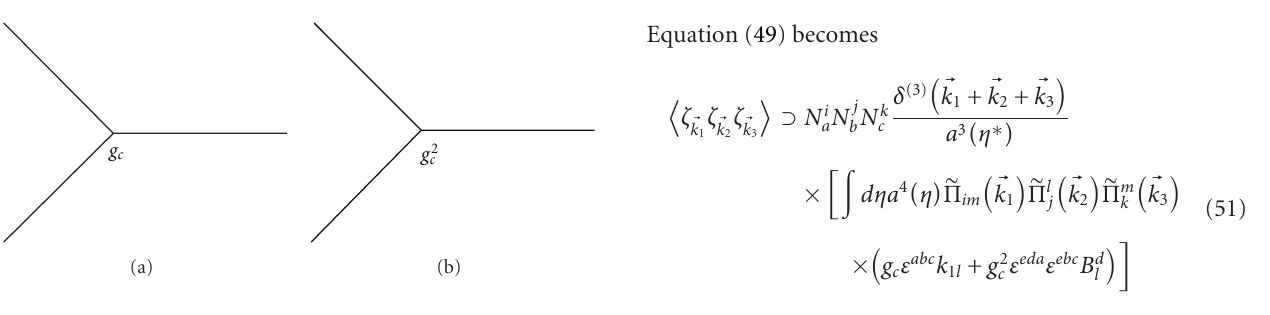
Figure 1: Diagrammatic representations of the tree-level contribu- tions to the vector fields